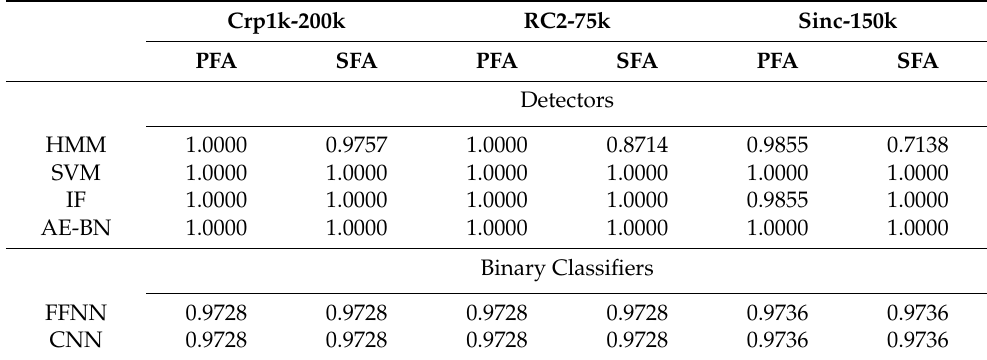
Table 6. Matthews correlation coefficient (MCC) of classifiers depending on feature sets and datasets.